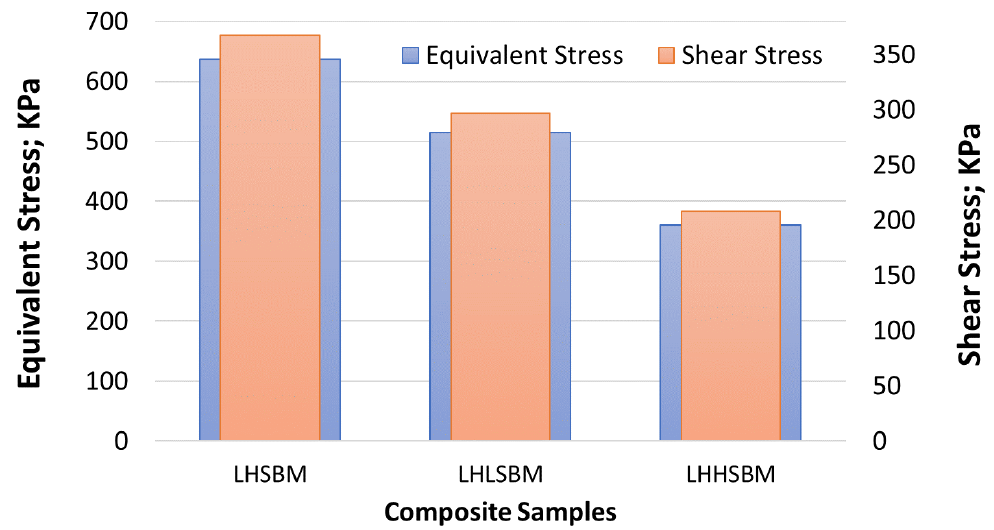
Crystals 2021 , 11 , x FOR PEER REVIEW Figure 19. Equivalent and shear stress on the surface of the Al/SiC composites.